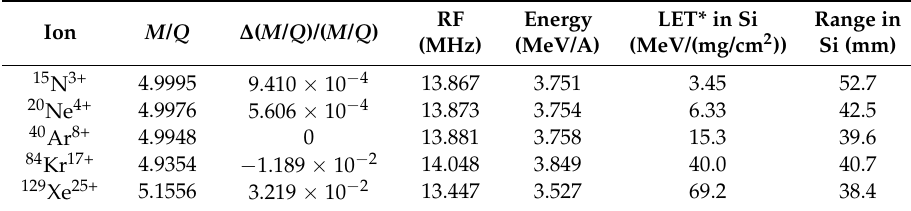
Table 3. List of cocktail ions with M / Q ≈ 5. Each of the ∆ ( M / Q )/( M / Q ) is a difference from that of 40 Ar 8+ . LET and range in Si were calculated using the SRIM code [13].